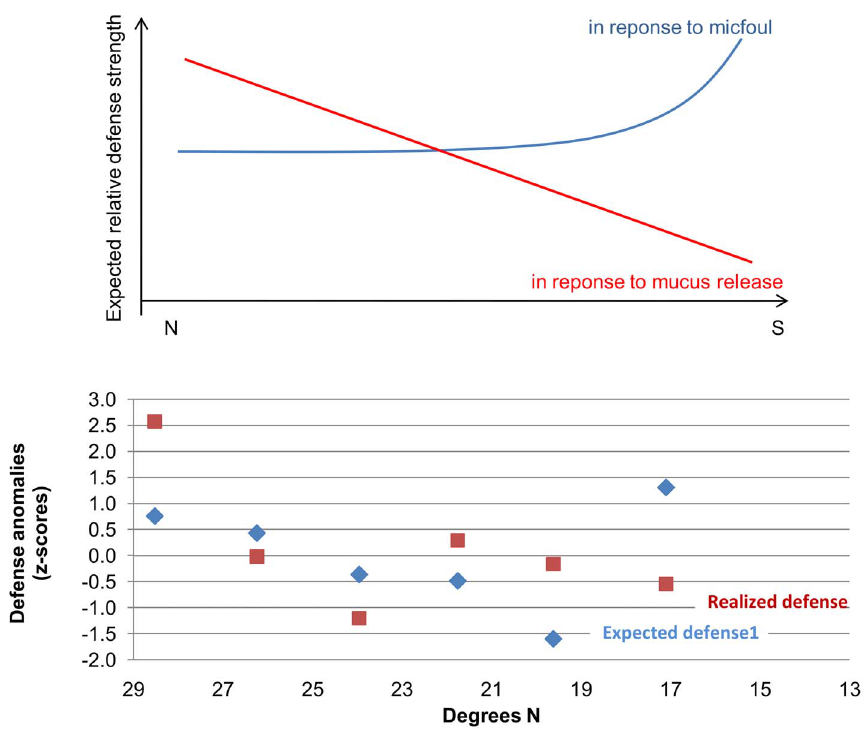
Fig. 7. Expected versus realized chemical antimicrofouling response. Upper panel: Theoretical response of chemical antifouling defense to the large scale patterns of microfouling pressure and mucus release detected along the Saudi Arabian coast. Lower panel: Expected defense pattern calculated as z-scores of microfouling pressure (supposedly positively related to chemical defense) minus the z-scores of mucus release (supposedly negatively related to chemical defense) and the pattern of realized